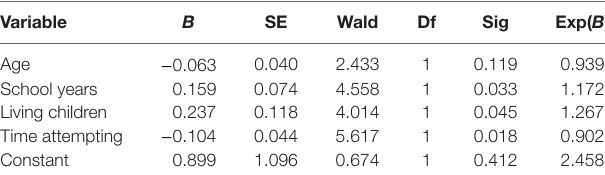
Table 4 | Logistic regression analysis of the likelihood of achieving pregnancy.